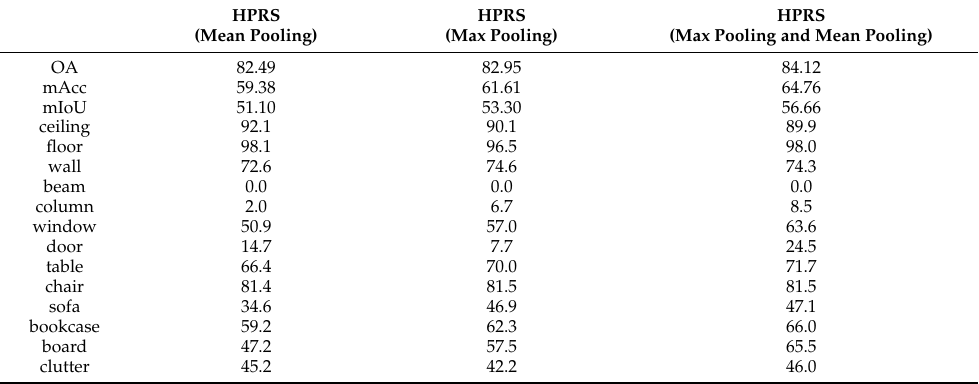
Table 6. Quantitative results of different grouping algorithms within the same HPRS network for the Area 5 (%). Table 7. Quantitative results of different pooling methods within the same HPRS network for the Area 5